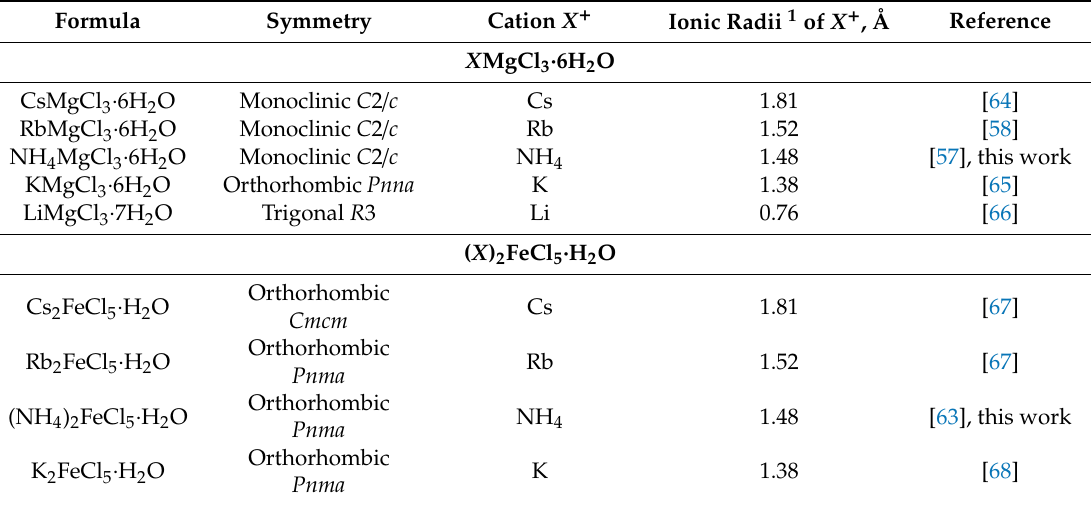
Table 12. Compounds with formulas X MgCl 3 · 6H 2 O and ( X ) 2 FeCl 5 · H 2 O. Formula Symmetry Cation X + Ionic Radii 1 of X + , Å Reference X MgCl 3 · 6H 2